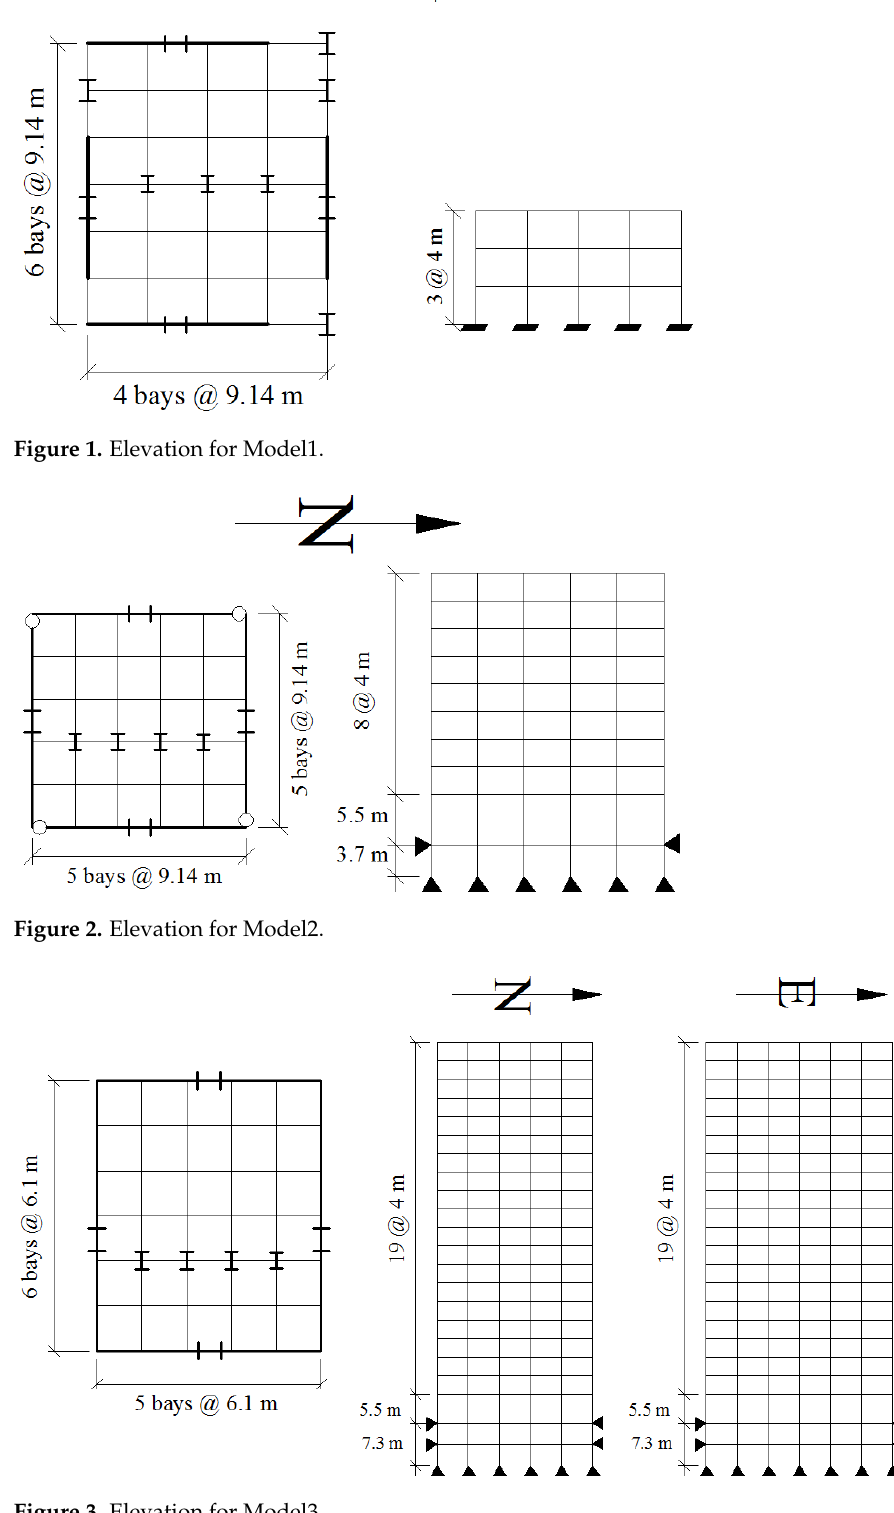
Figure 3. Elevation for Model3 .